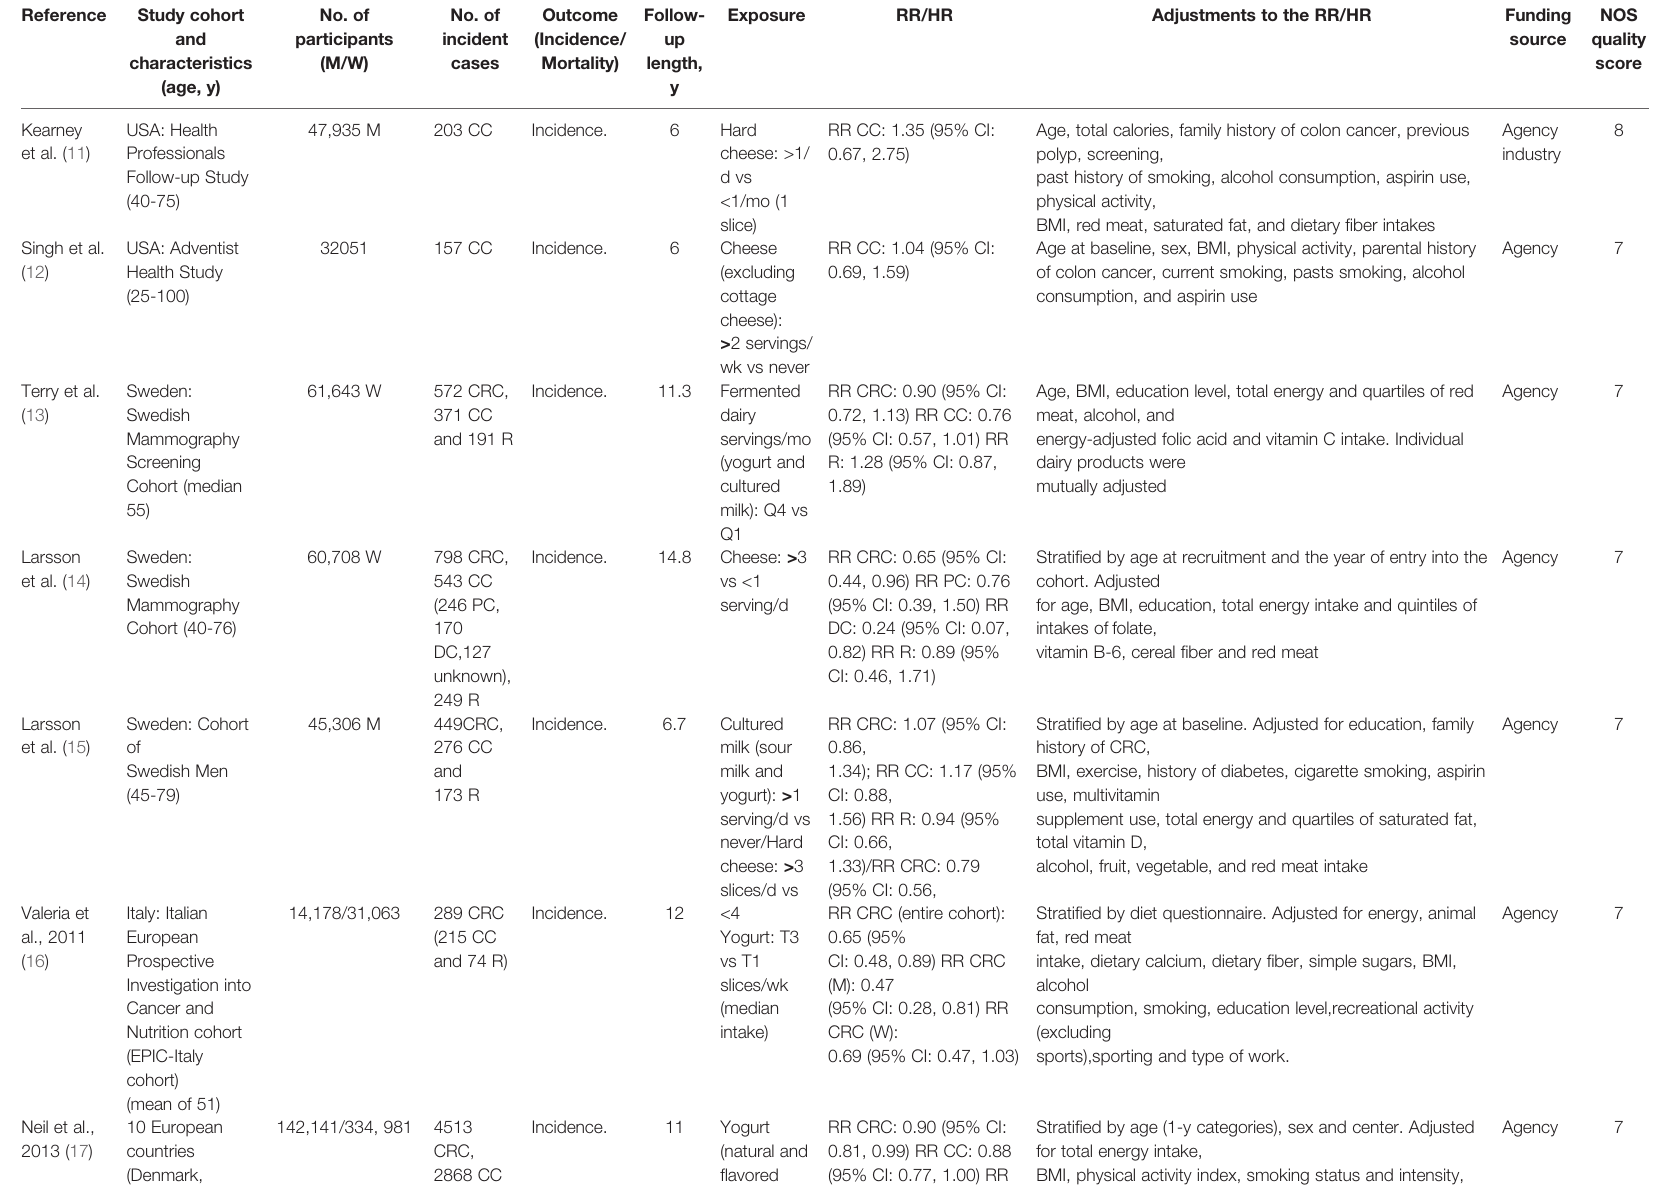
TABLE 2 | Characteristics of literatures included in the meta-analysis. Reference Exposure RR/HR Adjustments to the RR/HR Funding